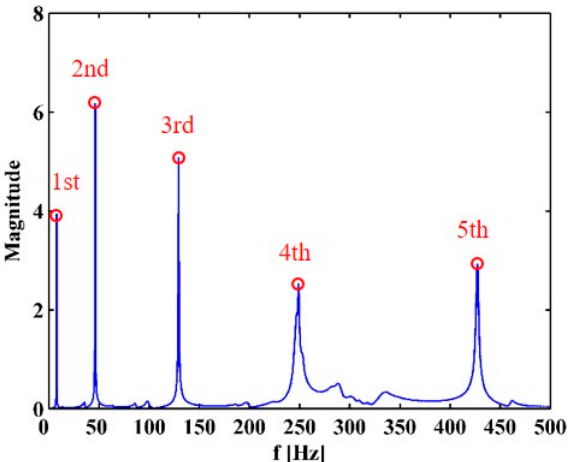
Figure 12. Schematic of experimental vibration measurement.